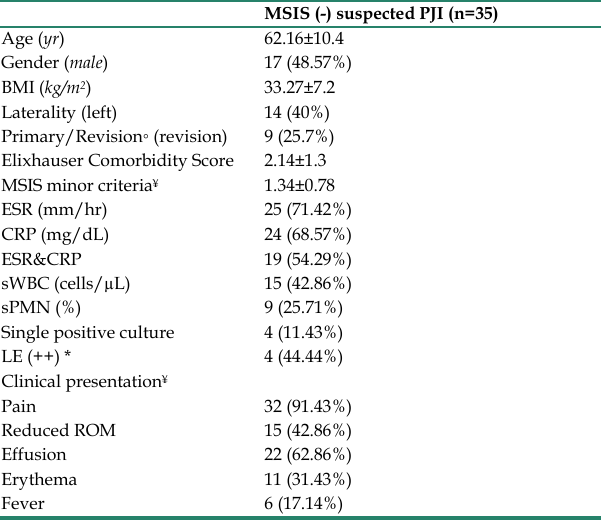
Table A. Characteristics, laboratory and clinical findings of a sub-group of patients diagnosed and treated for suspected infection although not meeting MSIS criteria for infection